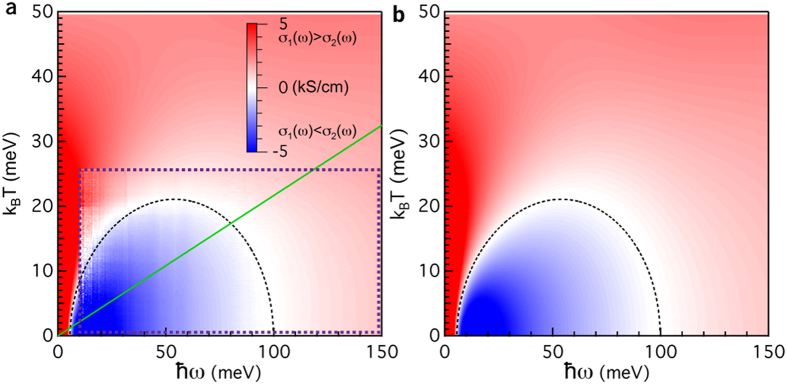
Fermi liquid behaviour of the optical conductivity: theory vs. experiment.(a) (ω, T) dependence of Δσ (ω, T) ≡ σ1 (ω, T)−σ2(ω, T). The experimental data is bounded by the purple dashed box, while the background image is the same as in panel b. Colour is used to indicate the magnitude of Δσ (ω, T), with red indicating the dissipative regime (σ1 (ω, T) > σ2 (ω, T)) and blue indicating the inductive regime (σ1 (ω, T) < σ2 (ω, T)). The colour scale is chosen such that the boundary between these two regimes, where (σ1 (ω, T) ≈ σ2 (ω, T), or Δσ (ω, T) ≈ 0, appears as white. This dome of zeroes can be reproduced using the approximate expression T∞ (ω). The green line indicates the crossover temperature 1.47πkBT = , below which Fermi liquid behaviour can be expected. (b), Same as in panel a, but calculated from the Allen-Kubo formula for the optical conductivity using a Fermi liquid self-energy with parameters derived from the experimental data of Fig. 1. The dashed semi-circle is the same as in panel a.